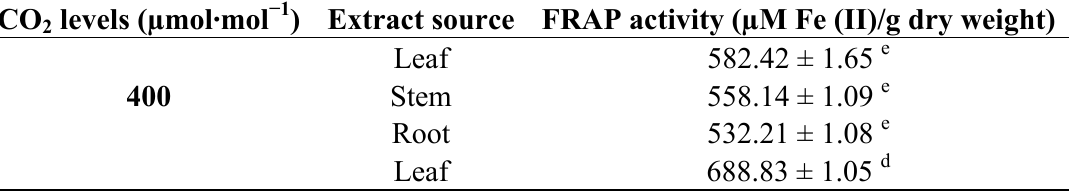
Table 5. Total antioxidant (FRAP) activity in different parts of three varieties of Elaeis guineensis under different CO levels. BHT, α -tocopherol and vitamin c were 2 used as positive